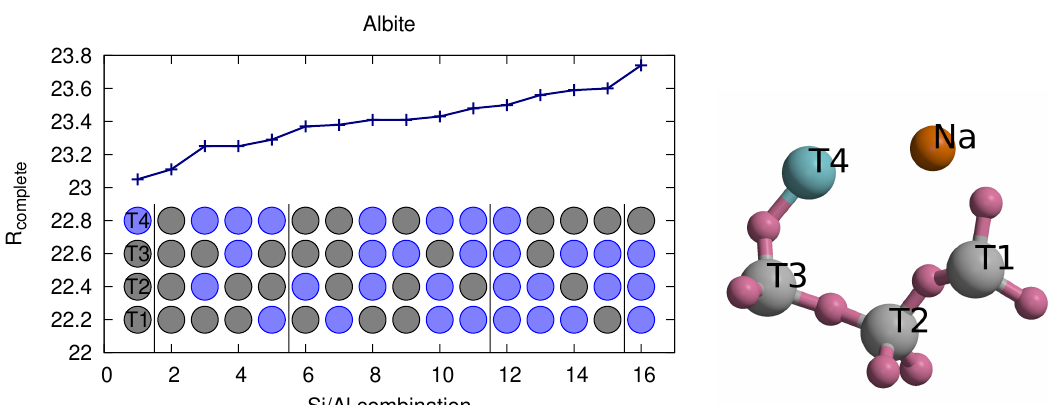
Figure 2. Left: R complete for all 16 combinations for assigning aluminum (blue circle) and silicon (grey circle) to the four T-sites in albite, sorted increasingly. The lowest R complete corresponds to the correct combination T 1 = T 2 = T 3 = Si and T 4 = Al . R complete increases with the number of wrongly assigned element types (grouped by vertical lines). Atom coordinates and one isotropic ADP value were refined for each atom site without restraints, and until convergence was reached (no parameter drift). Right: Asymmetric unit of albite with labelling of the four T-sites. T4 corresponds to aluminium. Oxygen atoms red, the sodium ion in